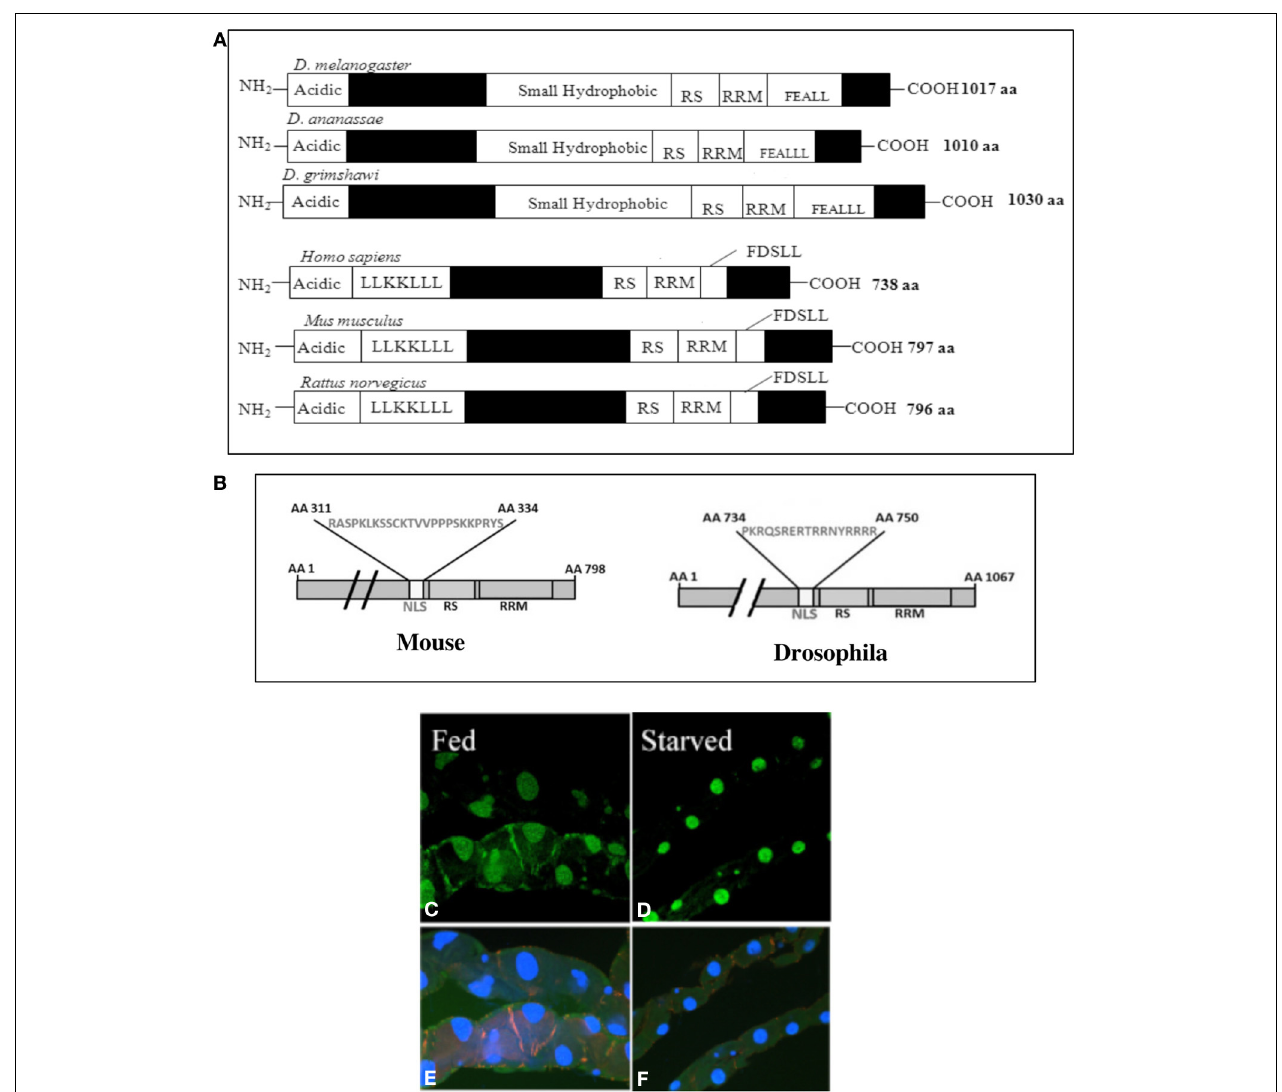
FIGURE 1 | (A) ComparisonoftheSpargel/dPGC-1proteinstructurein3widely divergent subgroups of Drosophila melanogaster , D. ananassae , and D. grimshawi (van der Linde and Houle, 2008). Vertebrate PGC-1 is about 300 amino acids shorter in length than the Spargel/dPGC-1. Filled boxes represent regions of non-homology. (B) An authentic Nuclear Localization Signal (NLS)